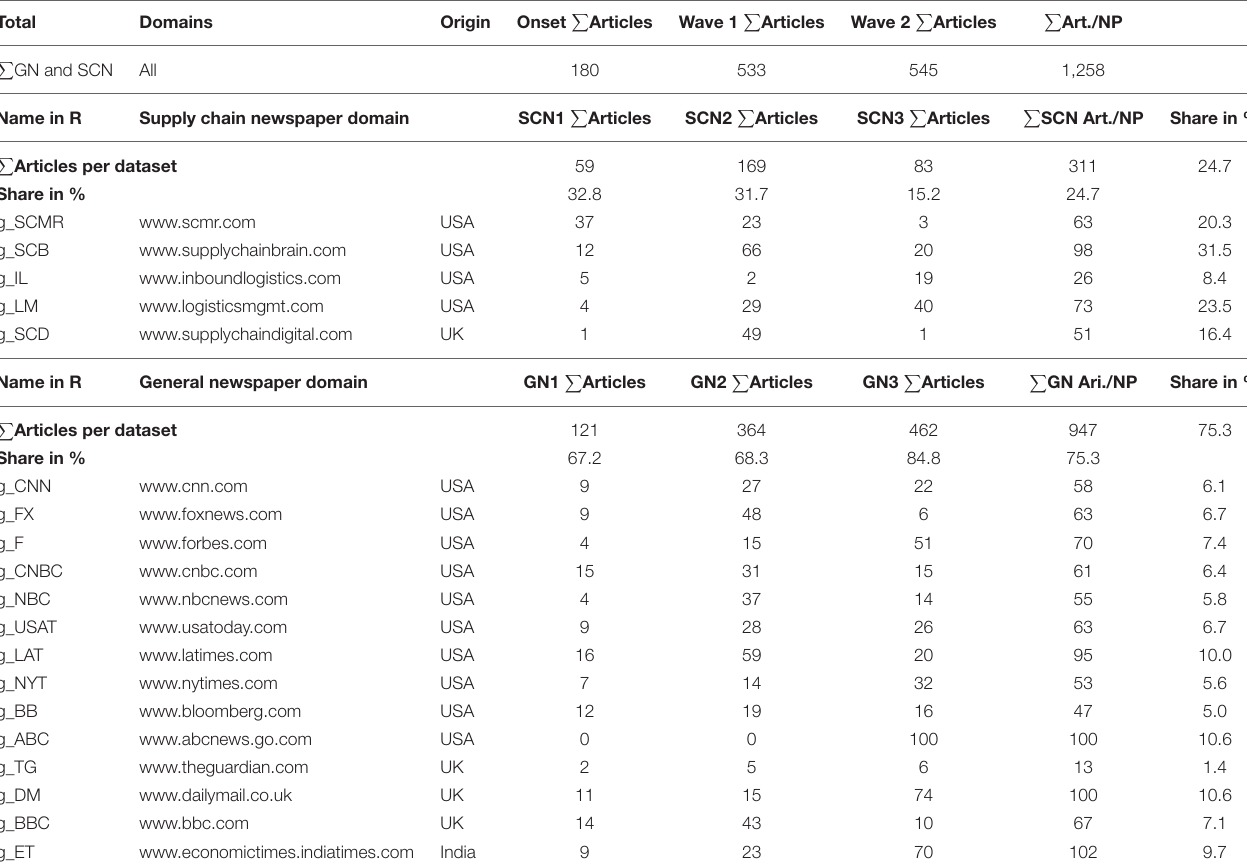
TABLE 2 | Summary of the number of articles per dataset, time frame, and